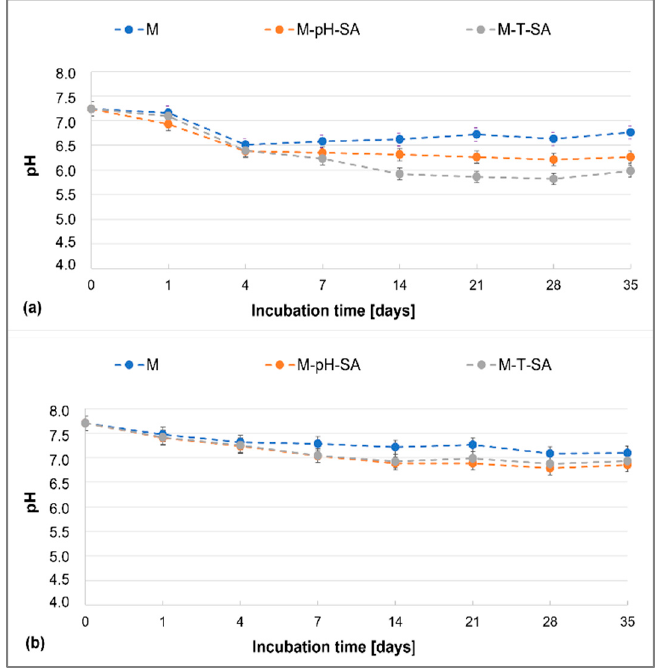
Figure 2. Changes in pH of the basic matrix (M), the system with a pH-sensitive nanocarrier and salicylic acid (M-pH-SA), and system with a thermosensitive nanocarrier and salicylic acid (M-T-SA) at 37 °C during 35-day tests of bio-hybrid hydrogels in ( a ) PBS and ( b ) SBF ( n = 3).